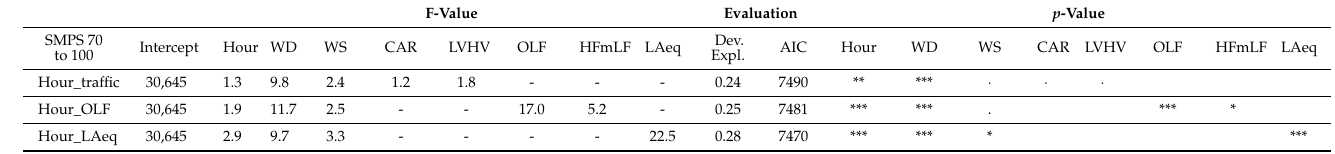
Figure 10. GAM models for the SMPS size fraction 70 to 100 nm, including the hour of the day as a covariate for three models: the traffic parameters (top), the spectral noise parameters (mid) and LAeq (bottom). Table 5. Summary of the GAM models one size fraction (SMPS 70 to 100 nm), including the hour of the day as a covariate for the traffic parameters, the spectral noise parameters and LAeq. F-Value Evaluation p